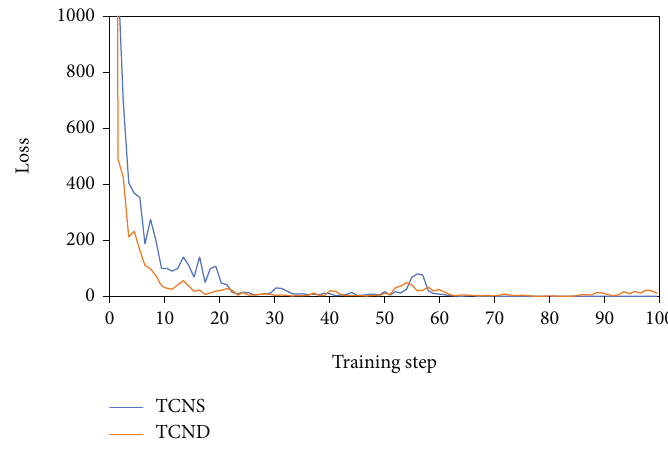
Figure 11: Loss curves of the network training set for the proposed two TCN models.